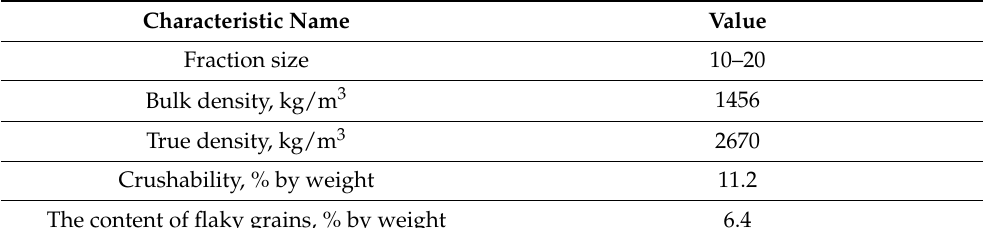
Table 3. Properties of the granite crushed stone.